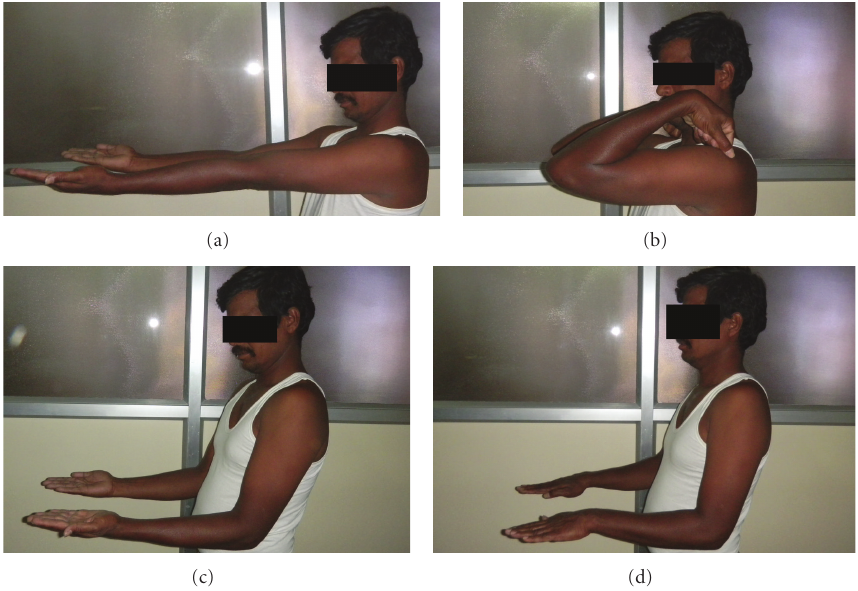
Figure 3: (a)–(d) Clinical photographs of the patient showing ROM at the final followup.